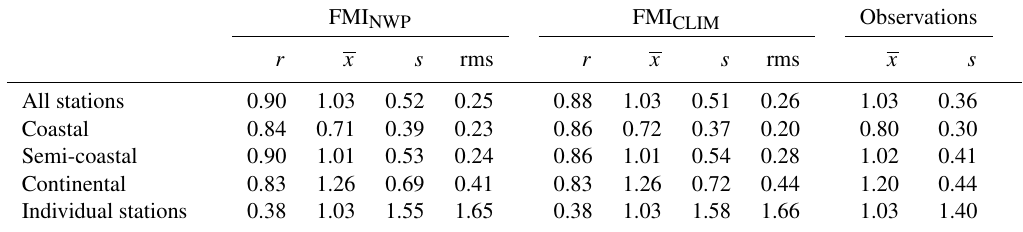
Table 3. Statistics calculated from numbers presented in Fig. 3. Correlation coefficient of algorithm results compared to the observations ( r ), mean value ( x ), standard deviation ( s ), and rms error of annual mean numbers of FZRA cases per station averaged over all stations, averaged over groups based on distance to the nearest coastline, and in individual stations are